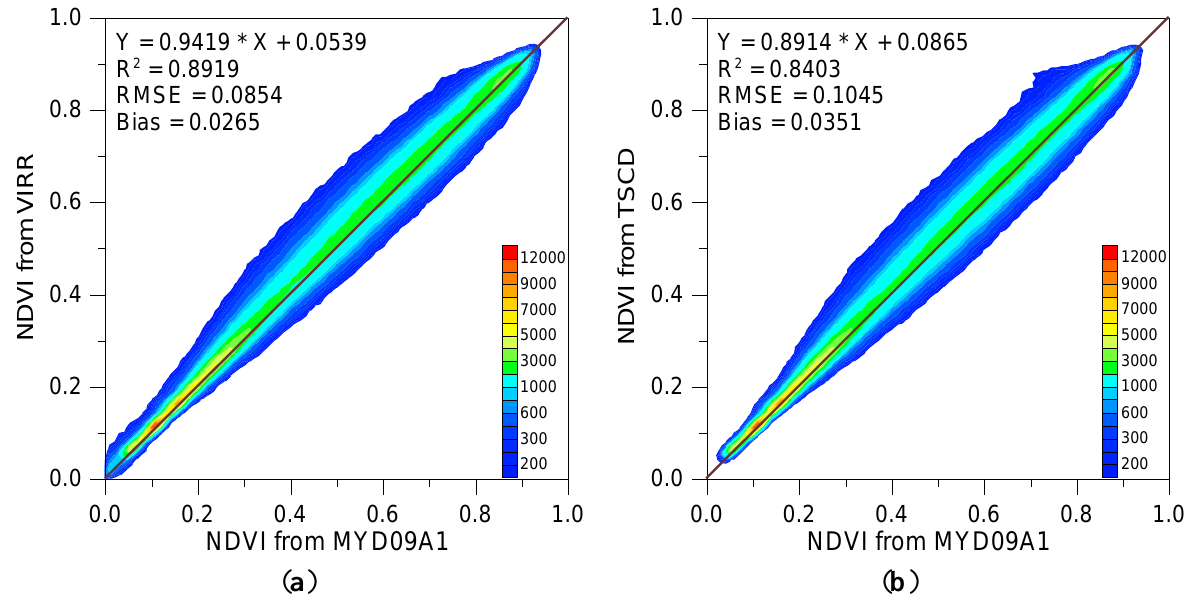
Figure 5. Density scatterplots of the NDVI values calculated from the reconstructed surface reflectance from the VIRR ( a ) and TSCD ( b ) algorithms versus the NDVI values calculated from the cloud-free surface reflectance from MYD09A1 over the BELMANIP sites in